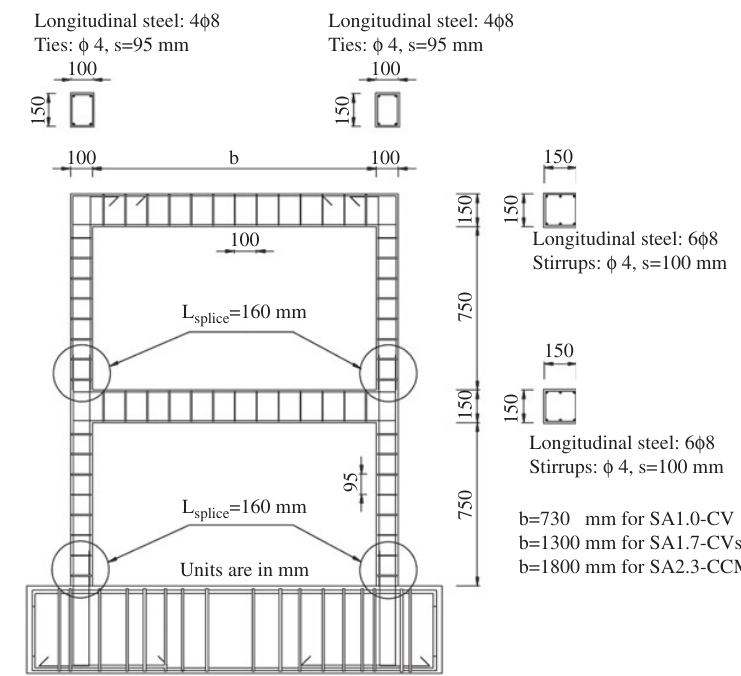
Figure 1 Reinforcement detail of